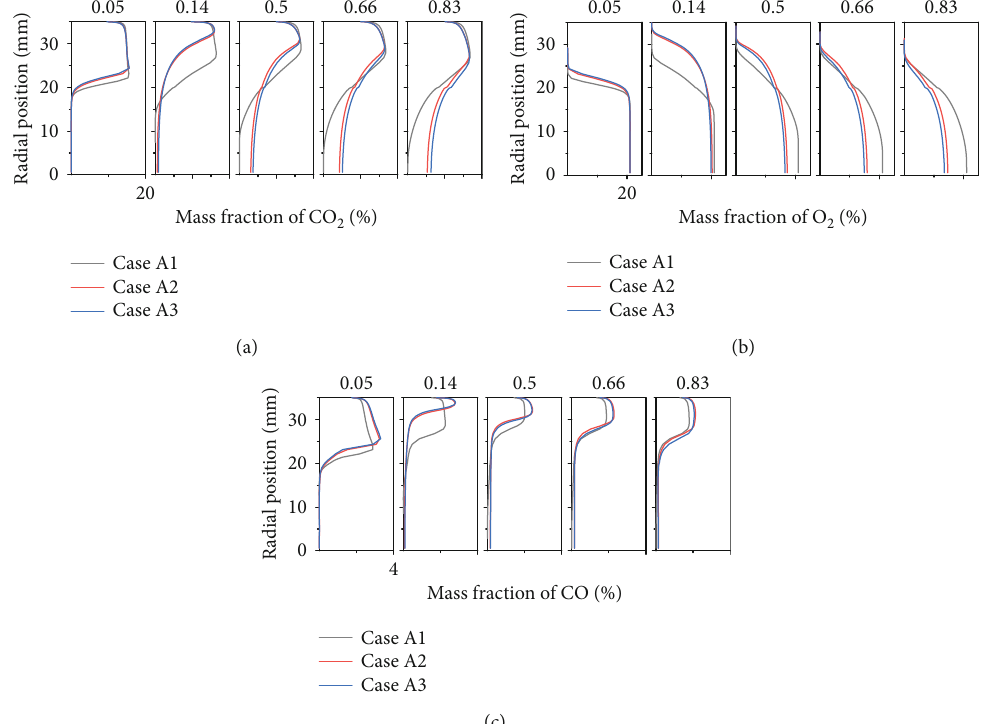
Figure 17: Radial pro fi les of the mass fraction of CO